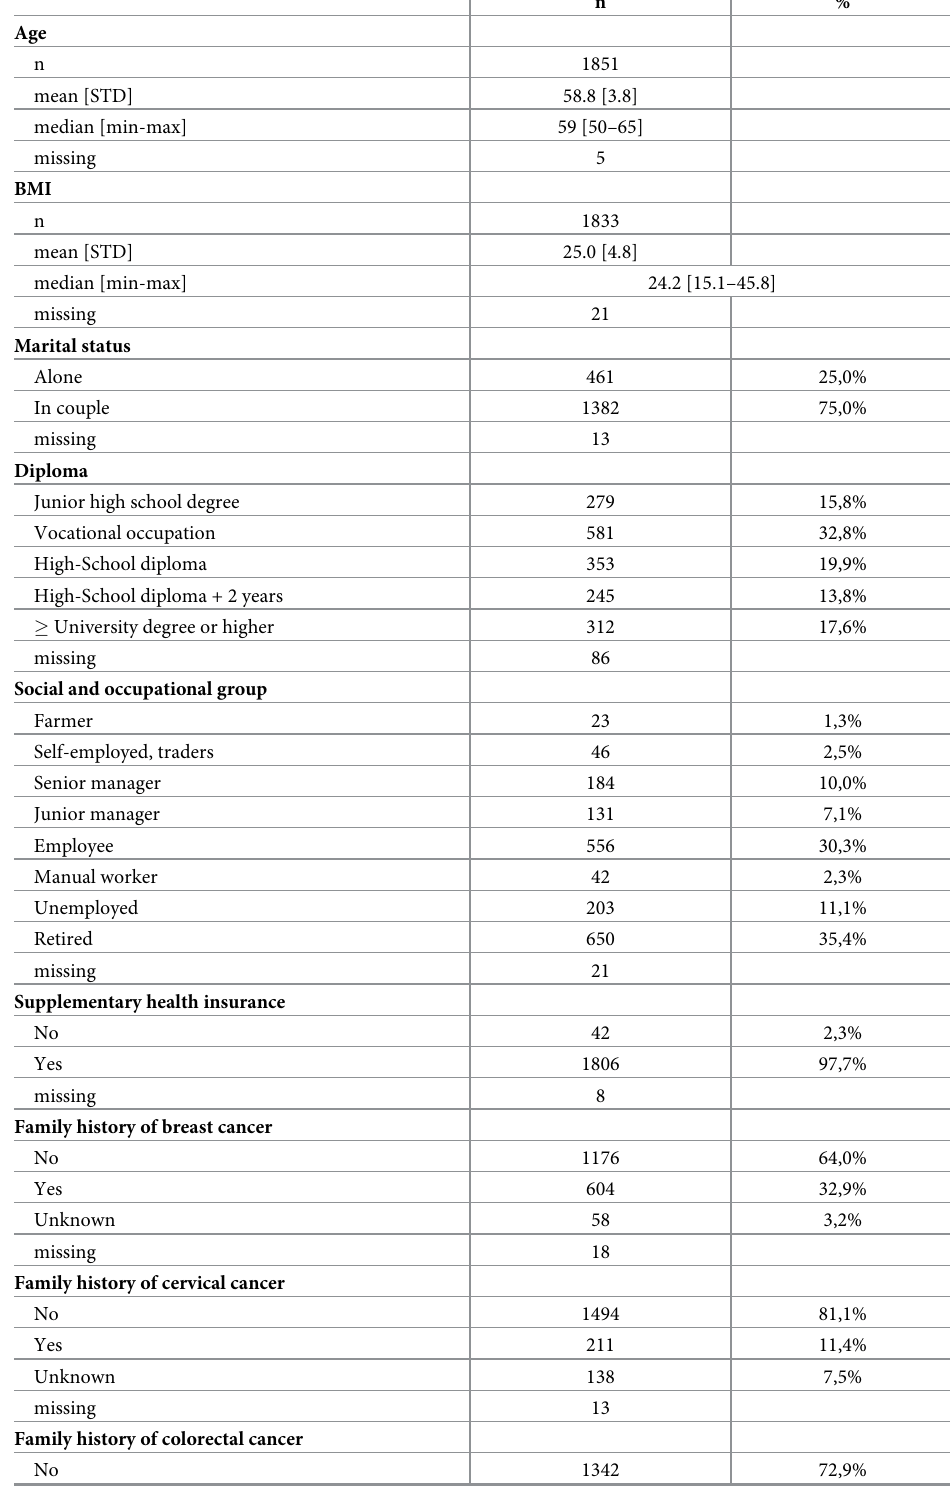
Table 1. Socio-demographic characteristics of the